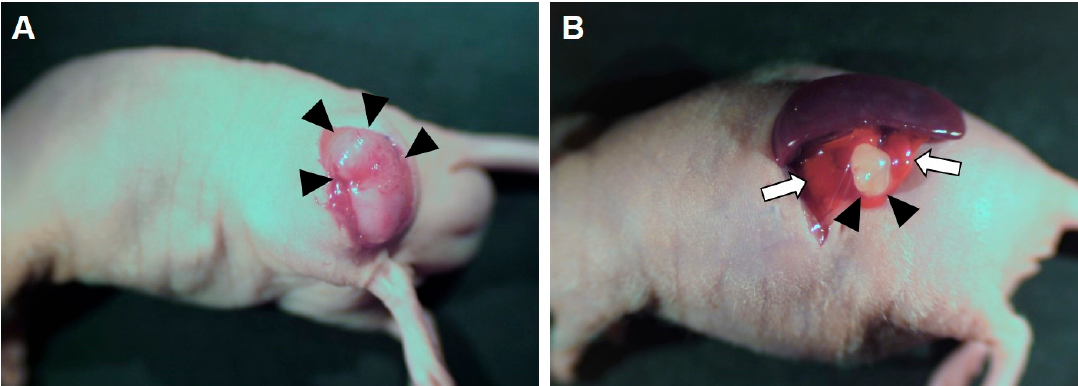
Figure 2. Examples of PDOX models. ( A ) A soft tissue sarcoma PDOX model was established by implanting a tumor into the lower extremity of a nude mouse [27]. The tumor was exposed by cutting the skin. ( B ) A pancreatic cancer PDOX model was established by implanting a tumor into the tail of the pancreas of a red fluorescent protein (RFP)-expressing nude mouse [24]. Black arrowheads indicate grown tumors. White arrows indicate the RFP-expressing pancreas.